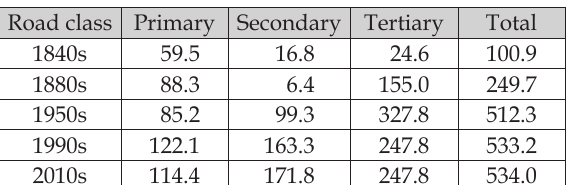
Table 2. lengths of road classes in the Hodonín region (in km) in the 1840s, 1880s, 1950s, 1990s, and